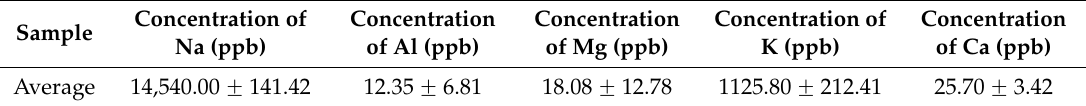
Table 5. Elements present in CMSC.